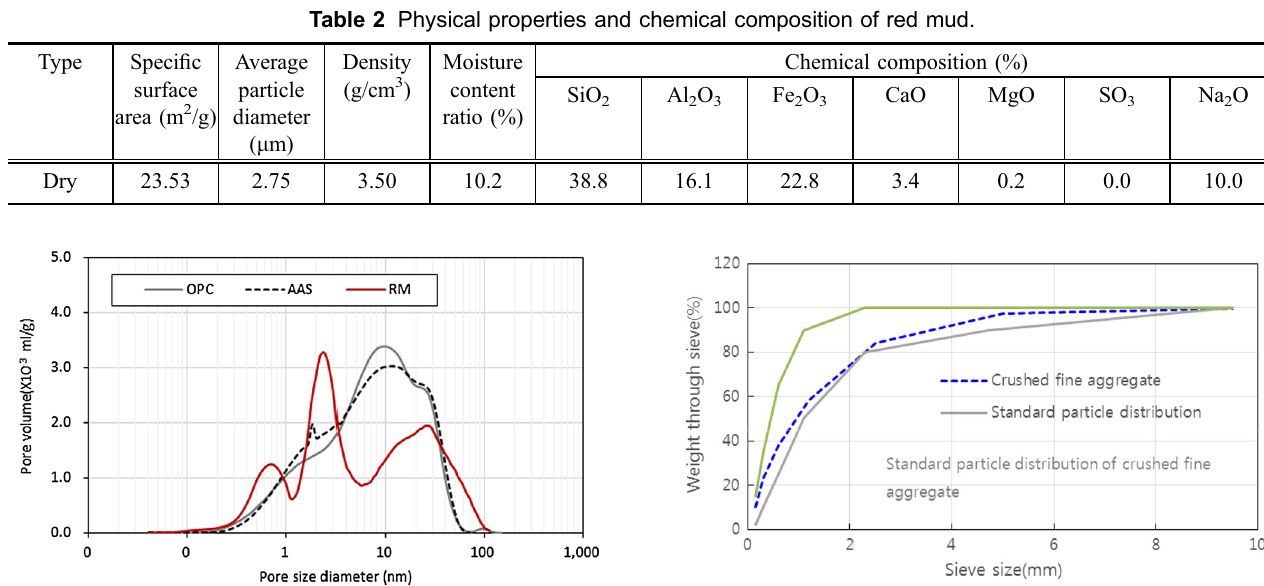
Fig. 2 Particle size distribution.